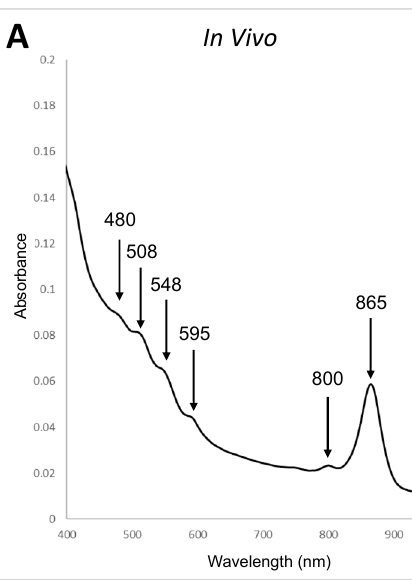
Figure 2. Absorbance spectra of E. tepida strain MS-P2 T . ( A ). An in vivo absorbance spectrum of strain MS-P2 T . The cells were grown in CTM medium under aerobic conditions in the dark and then were disrupted by ultrasonication. Absorbance maxima are indicated by the arrows. ( B ). Absorbance spectrum of pigments extracted from cells with acetone–methanol (7:2, v / v ). The absorbance maxima indicate the presence of BChl a and carotenoids. For additional details, see text. Similar results were obtained with cells grown in the